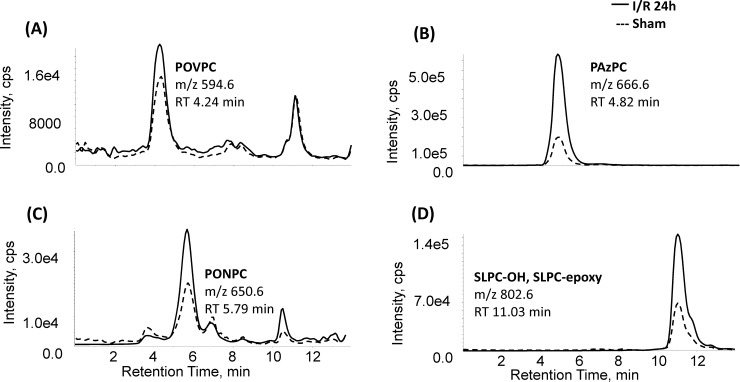
Fragmented and non-fragmented OxPC identified in rat renal tissue in sham operated and 24h I/R groups by LC/MS/MS.MRM chromatogram of (A) POVPC, (B) PAzPC, (C) PONPC and (D) SLPC-OH in renal tissue in I/R 24h (black line) and sham (dotted line) groups as measured by reverse phase HPLC-MS/MS. Abbreviations: POVPC, 1-palmitoyl-2-(5'-oxo-valeroyl)-sn-glycero-3-phosphocholine; PAzPC, 1-palmityl-2-azelayl-sn-glycero-3-phosphocholine; PONPC, 1-palmitoyl-2-(9'-oxo-nonanoyl)-sn-glycero-3-phosphocholine; SLPC-OH, 1-stearoyl-2-linoleoyl-phosphatidylcholine.